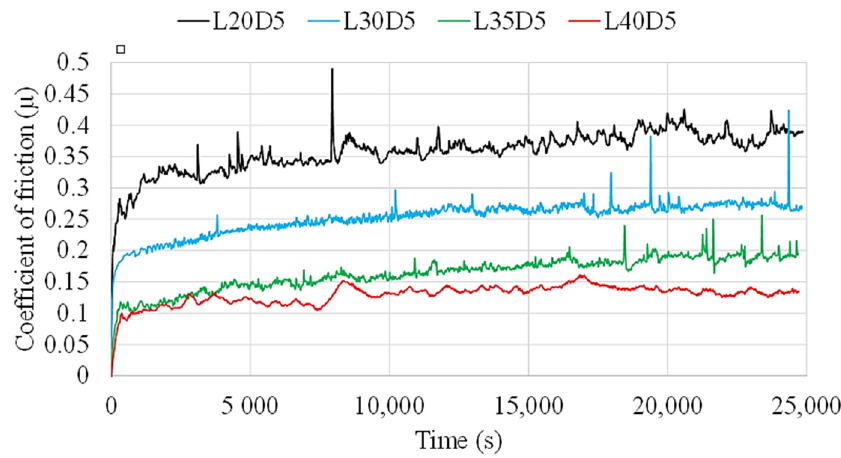
Figure 8. CoF evolution for the coating tested under different normal loads.